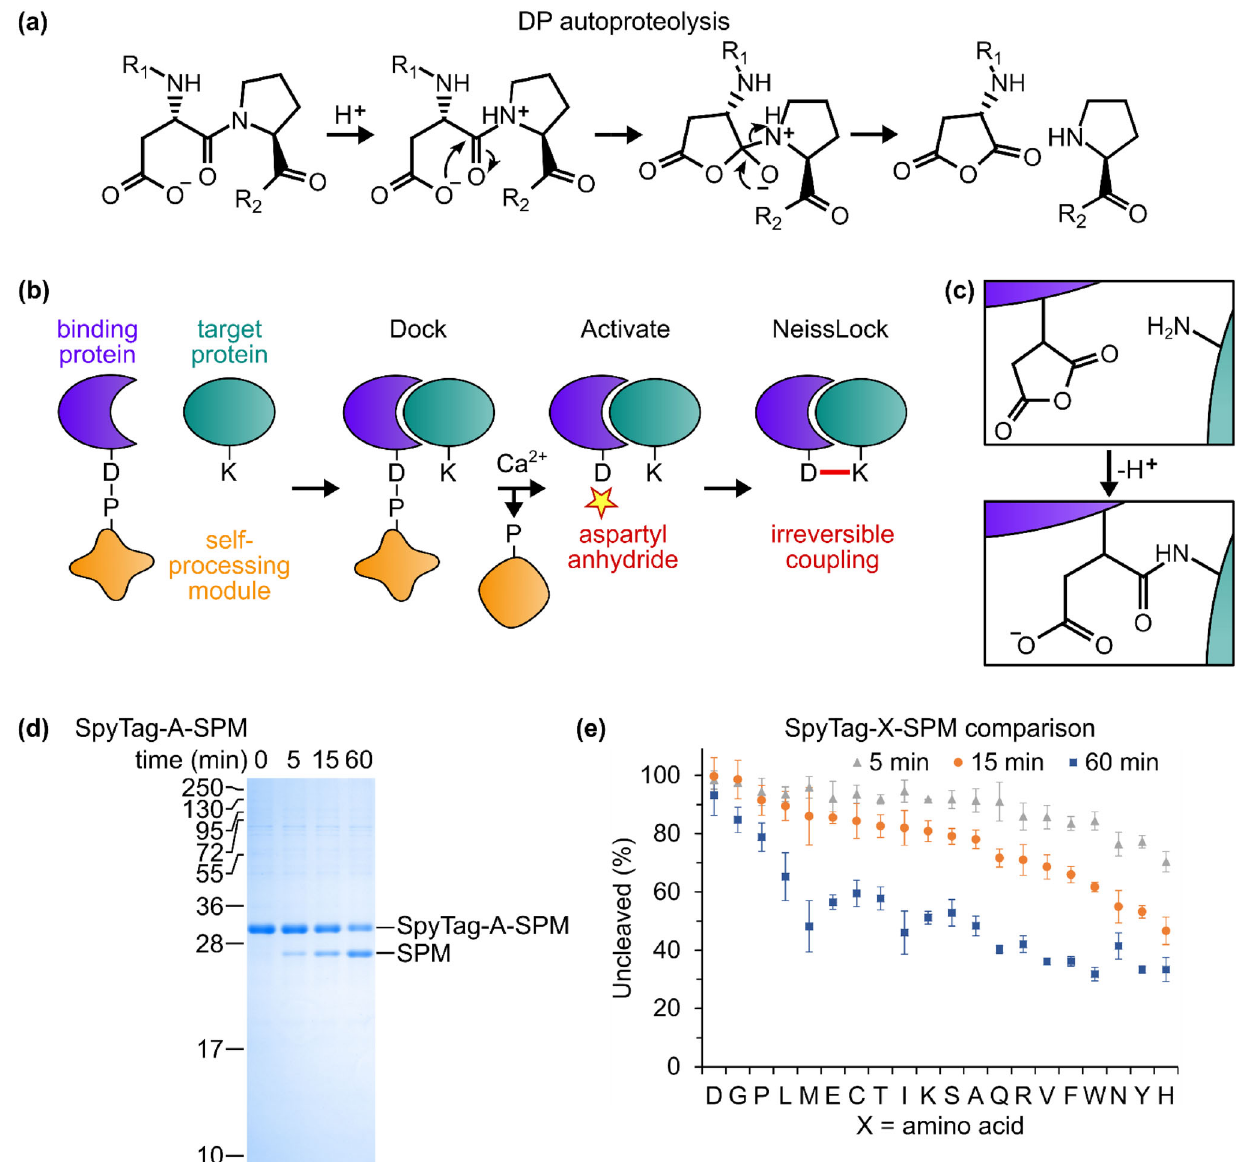
Fig. 1 The NeissLock concept and optimizing autoproteolysis. a The FrpC self-processing module (SPM) catalyzes autoproteolytic cleavage at an Asp-Pro peptide bond, induced by calcium, generating an anhydride. b NeissLock vision. SPM (orange) is recombinantly fused to a binding protein (blue) which docks with the target protein (green). Adding calcium promotes generation of the anhydride (yellow star), so the binding protein can form a covalent bond to the target protein. c Schematic of reaction of amine on target protein with aspartic anhydride on binding protein. d Time-course of SPM cleavage with Ala preceding Asp-Pro, analyzed by SDS-PAGE with Coomassie staining (pH 7.4, 37 °C). Molecular weight markers represent kDa. e Histogram of SPM cleavage rate with each residue before Asp-Pro, moving from the least cleaved residue at 15 min on the left to the most cleaved residue on the right (mean of triplicate± 1 s.d.; some error bars are too small to be visible; pH 7.4 and 37 °C. Source data are provided as a Source Data fi